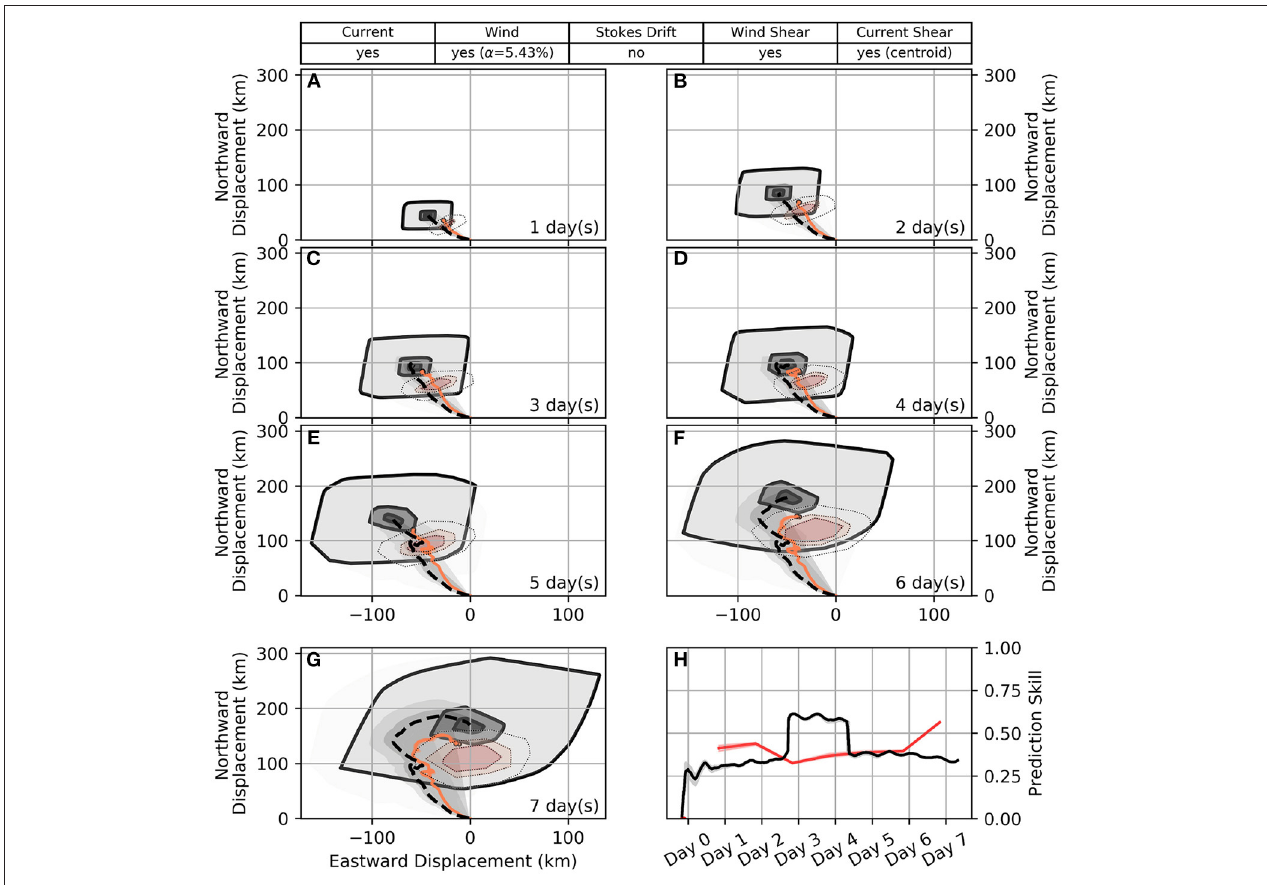
FIGURE 9 | Daily predicted tracks of the sphere drifters for 7 days after deployment using the indicated optimal forcing combination (A–G) , and a time series of model skill during this period (H) . Membership levels of the possible displacement, P ( j ) for j 0,1,2, are indicated in grayscale shading, increasing in intensity toward the = E x crisp solution ( j 3) which is indicated by the dashed black line. Equivalent results obtained using the leeway method are shown in red shading. Observed drifter = tracks are superimposed in orange. Model skill is also shown in grayscale for the optimal forcing combination and in red for the leeway method. Shading indicates the maximum and minimum skill for the ensemble of drifters, while the solid line indicates the mean. Red markers on the x-axis of the skill plot indicate times when at least one observed drifter fell outside of the lowest membership